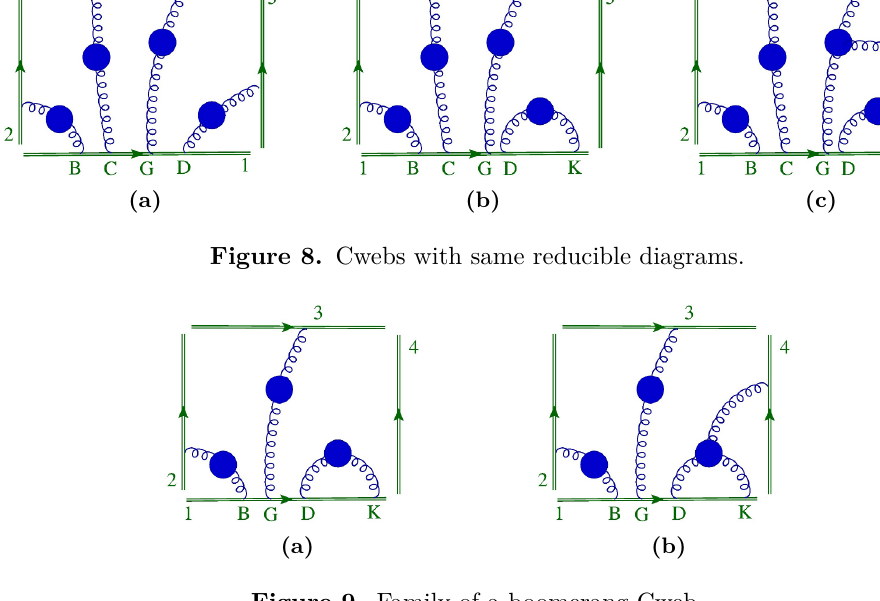
Figure 9. Family of a boomerang